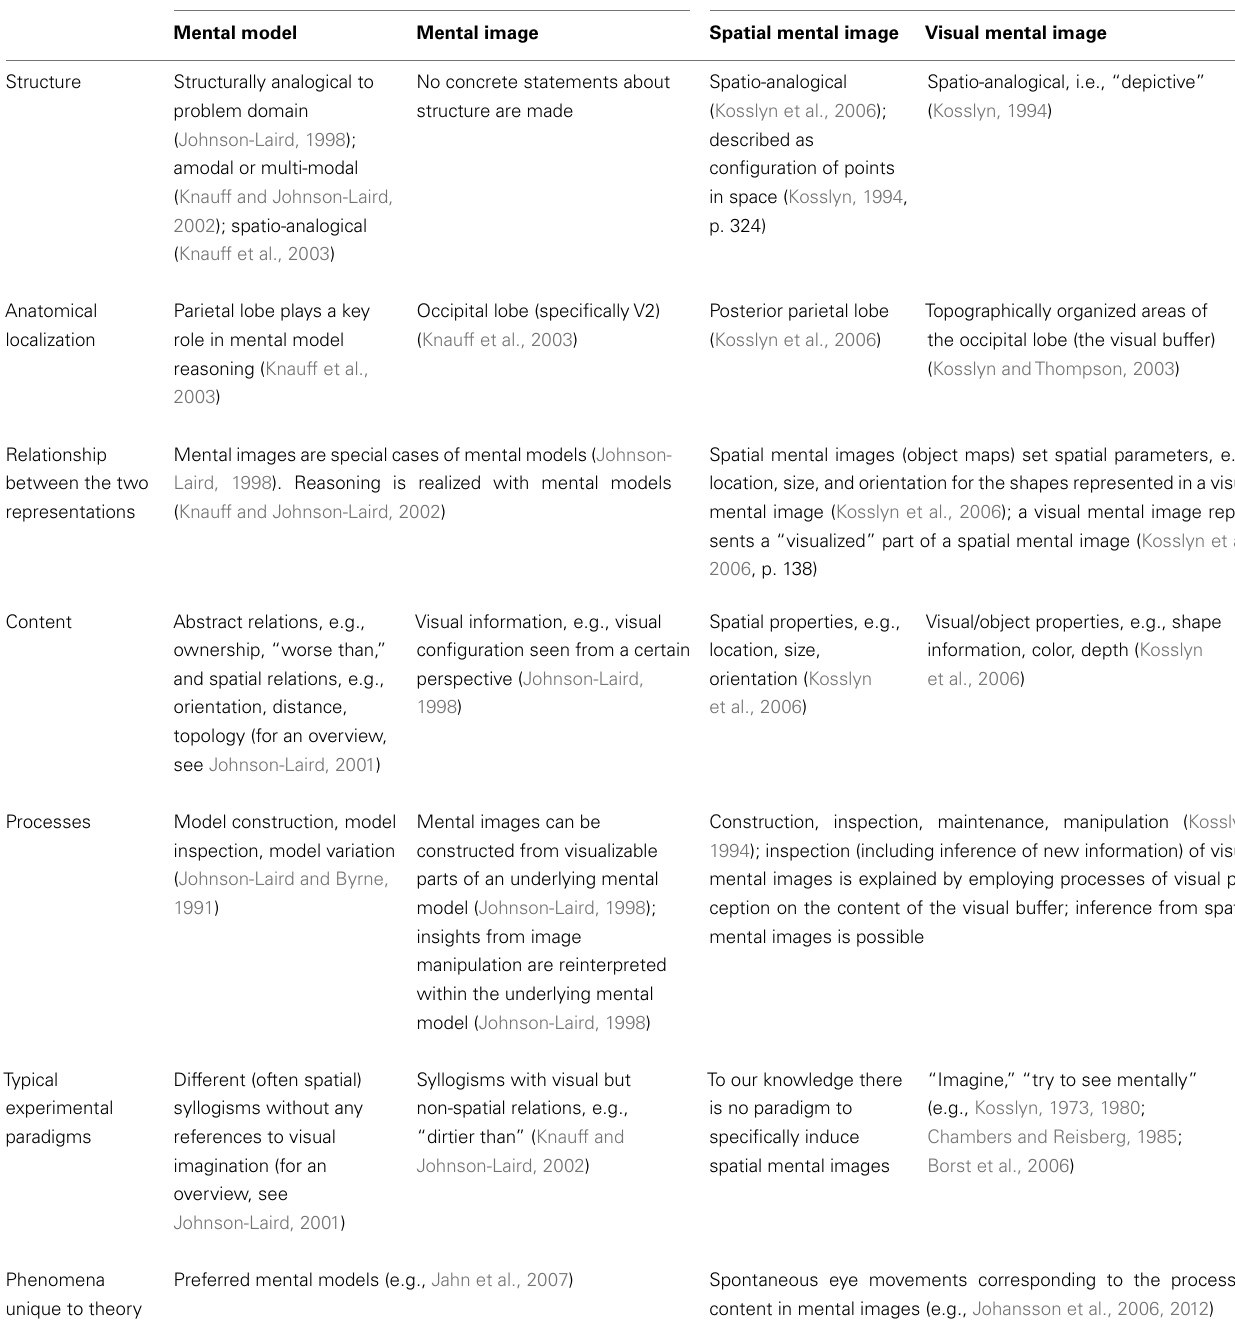
Table 1 | Comparison of mental model theory and the theory of mental images. Mental model theory Mental